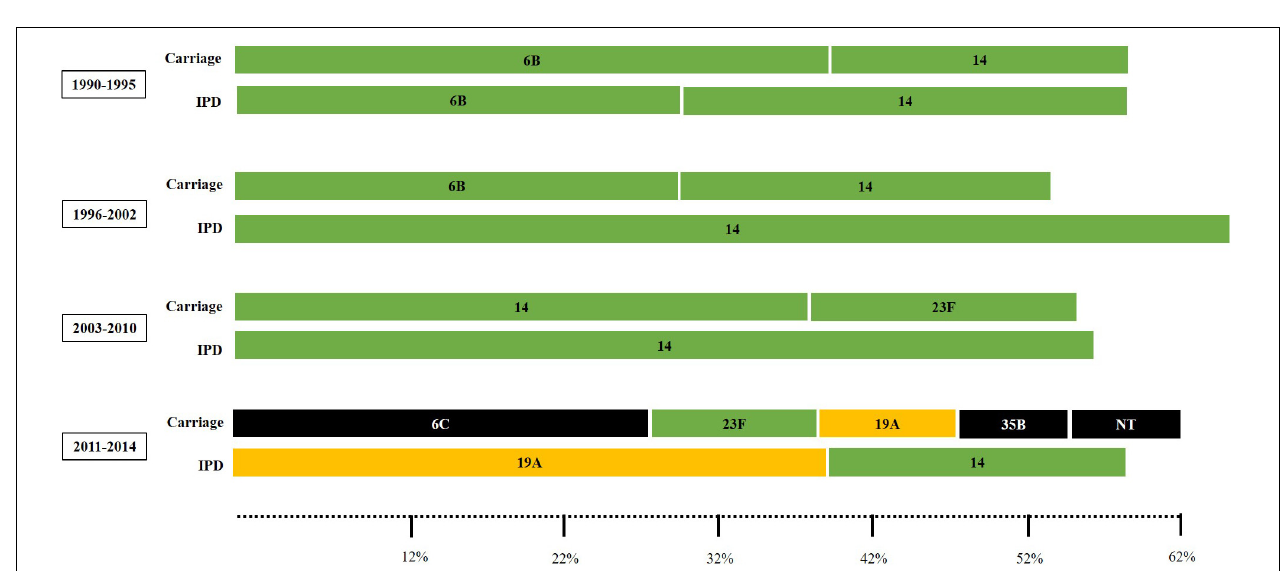
FIGURE 4 | Distribution over time of capsular types included in the 10-valent pneumococcal conjugate vaccine (PCV10; in green), of those included only in the 13-valent pneumococcal conjugate vaccine (PCV13; in yellow) and of those not included in any PCV currently available (in black) among penicillin non-susceptible pneumococci (PNSP).